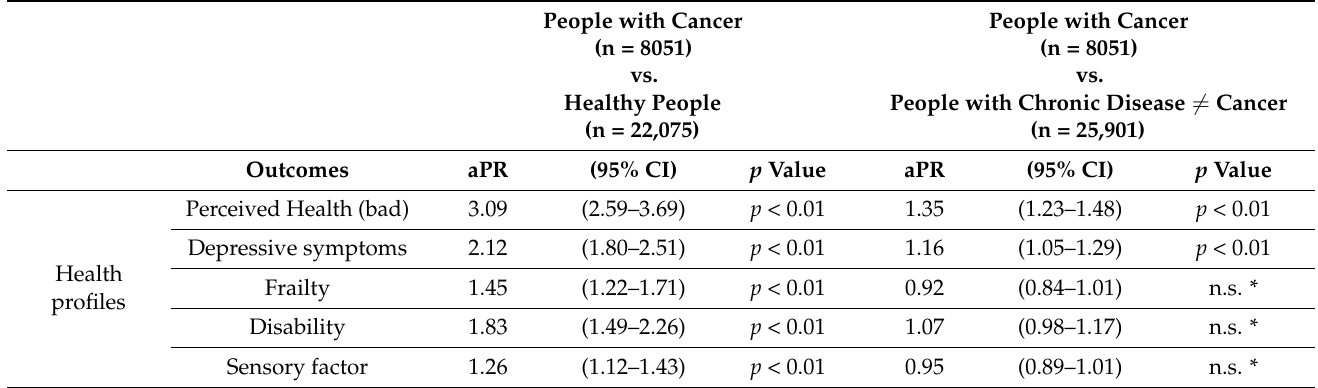
Table 3. Health profile among people aged ≥ 65 years with cancer compared to people with chronic disease other than cancer and healthy individuals. Passi d’Argento 2016–2019 (n = 56,027). Adjusted prevalence ratios–aPRs (by Poisson regression models) for comorbidity, age, gender, educational level, economic difficulties and regional macroarea with corresponding 95% confidence intervals (95% CI) and p -value. People with Cancer People with Cancer (n = 8051) (n = 8051) vs. vs. Healthy People People with Chronic Disease (cid:54) = Cancer (n = 22,075) (n =